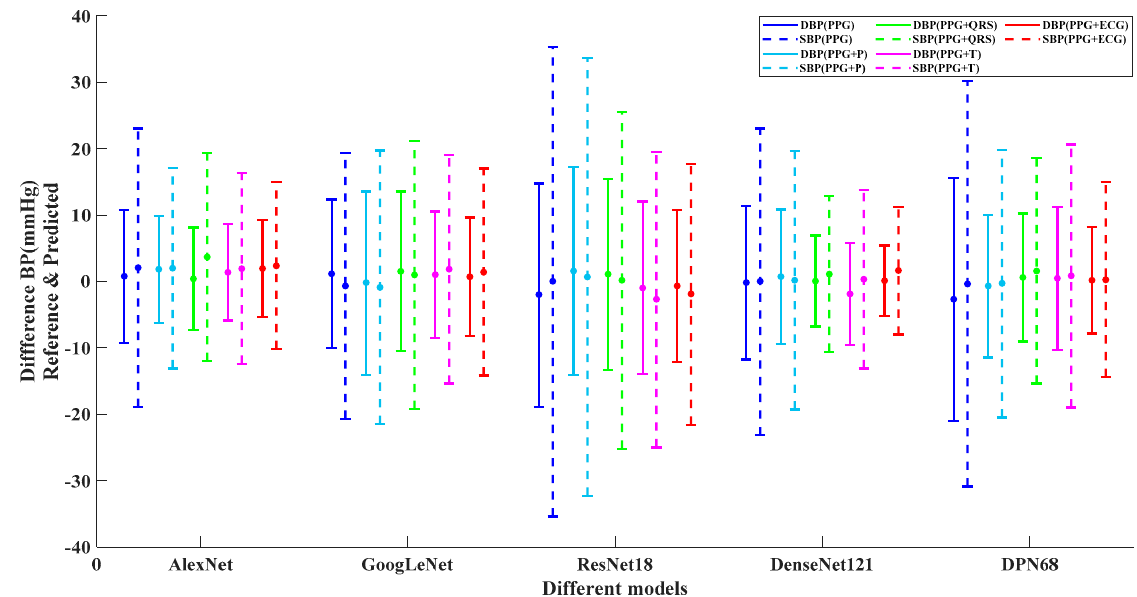
Figure 4. Mean and 95% CI plot for Different Models (solid dots represents mean value and short solid lines represent mean ± 1.96SD).